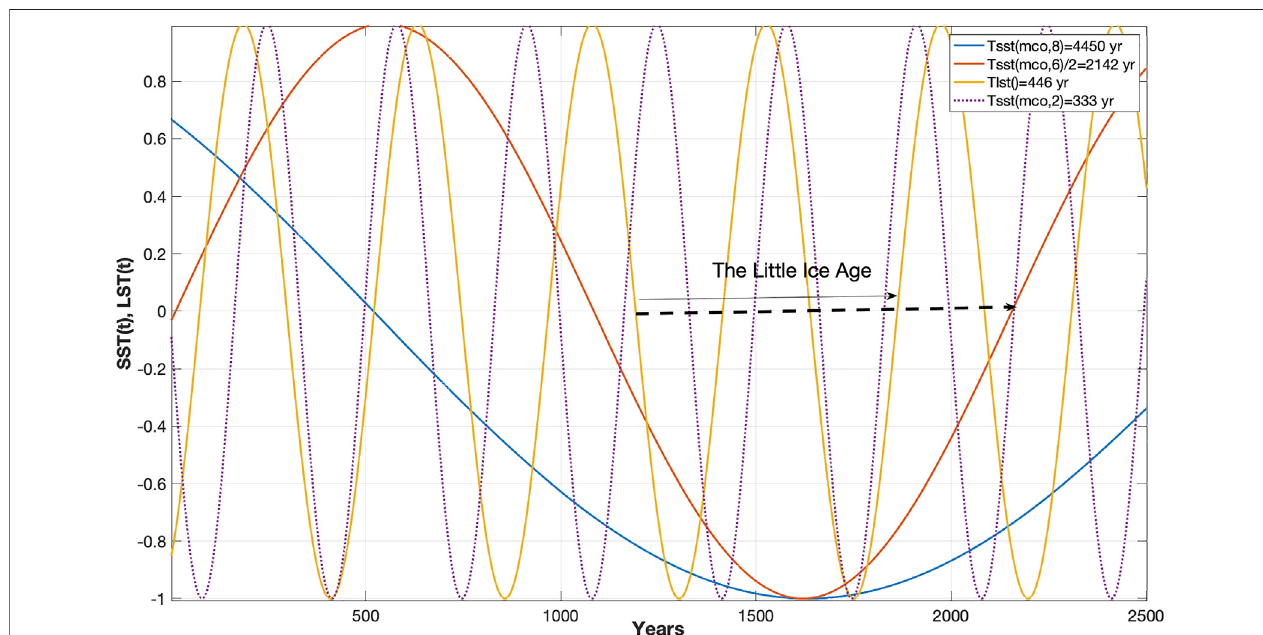
FIGURE 11 | Stationary solar forced sea temperature cycler [Tsst (mco, 8], Tsst-mco (7)/2, Tsst-mco (2) = (4450, 2142, 333) (yr.) and lunar forced temperature period, Tlst, of 446 years in the time period t = (0 ...